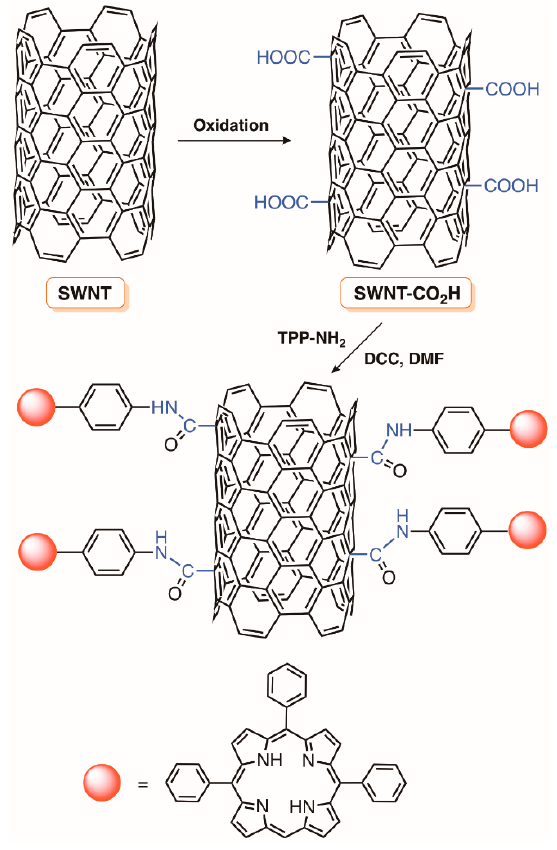
Figure 37. Preparation of SWNT and functionalization with TPP-NH 2 (adapted from Reference [193]).